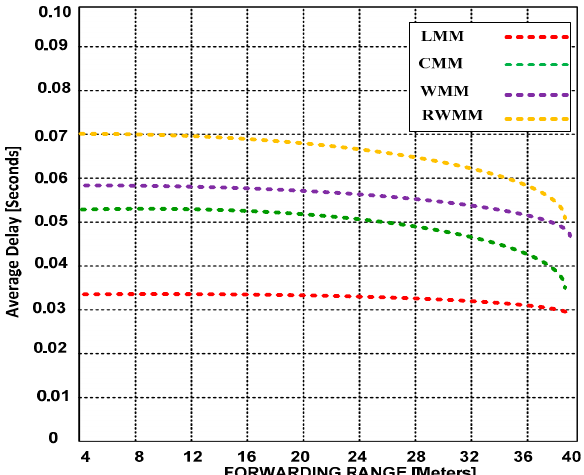
Figure 4. Average delay versus forwarding range at 25 m event range and 50% mobility.